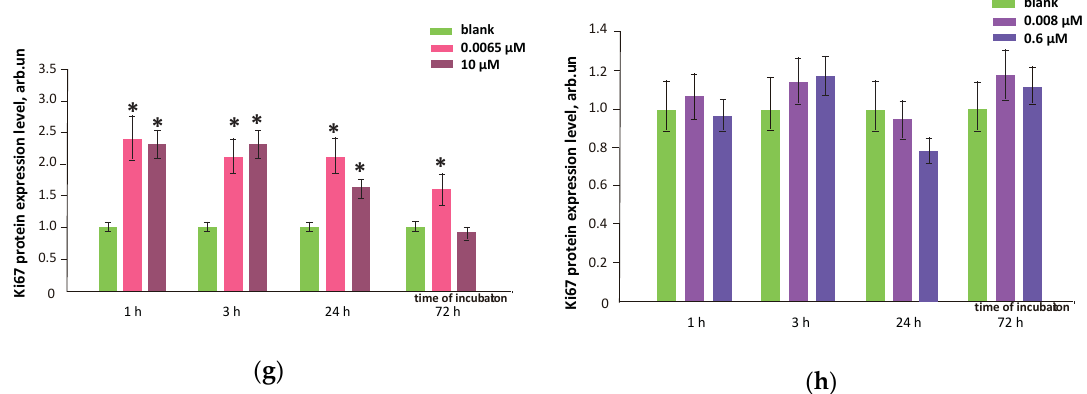
Figure 15. The expression of CCND1, CDKN2A and CDKN1A genes in HFLF as a result of treatment with ( a , c , e ) FF1 and ( b , d , f ) FF2 (concentrations are shown in figure). The RNA amount is the mean value of three experiments relative to blank. The TBP gene was used as an internal reference standard gene. Ki-67 protein level in HFLF treated with ( g ) FF1 and ( h ) FF2 (concentrations are shown in figure) relative to blank (cells with no fullerenes added). (*) marks significant differences with blank, p < 0.01, nonparametric U- test. In blank experiments, cells were incubated without the fullerenes.